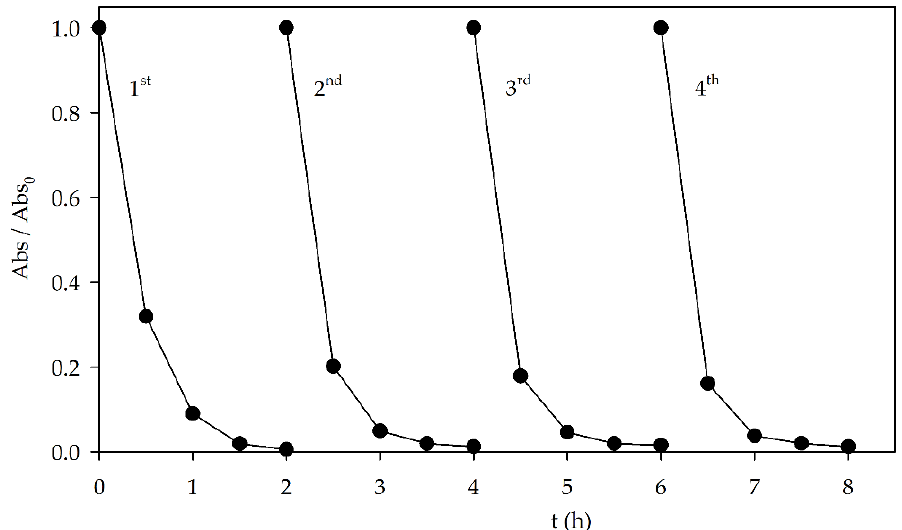
Figure 4. Reusability of the Sr 0.95 Bi 0.05 TiO 3 catalyst (0.2 g L −1 ) on the photocatalytic degradation of AO7 (10 mg L −1 ) under visible light, during four cycles. AO7 (10 mg L − 1 ) under visible light, during four